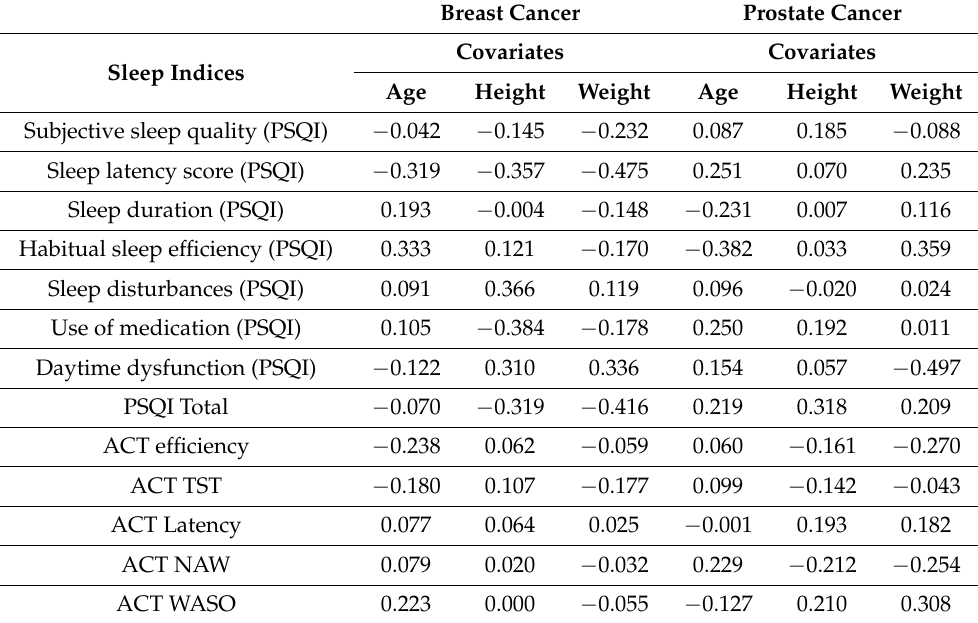
Table 2. Bivariate correlation between sleep indices and covariates in breast cancer and prostate cancer patients. Breast Cancer Prostate